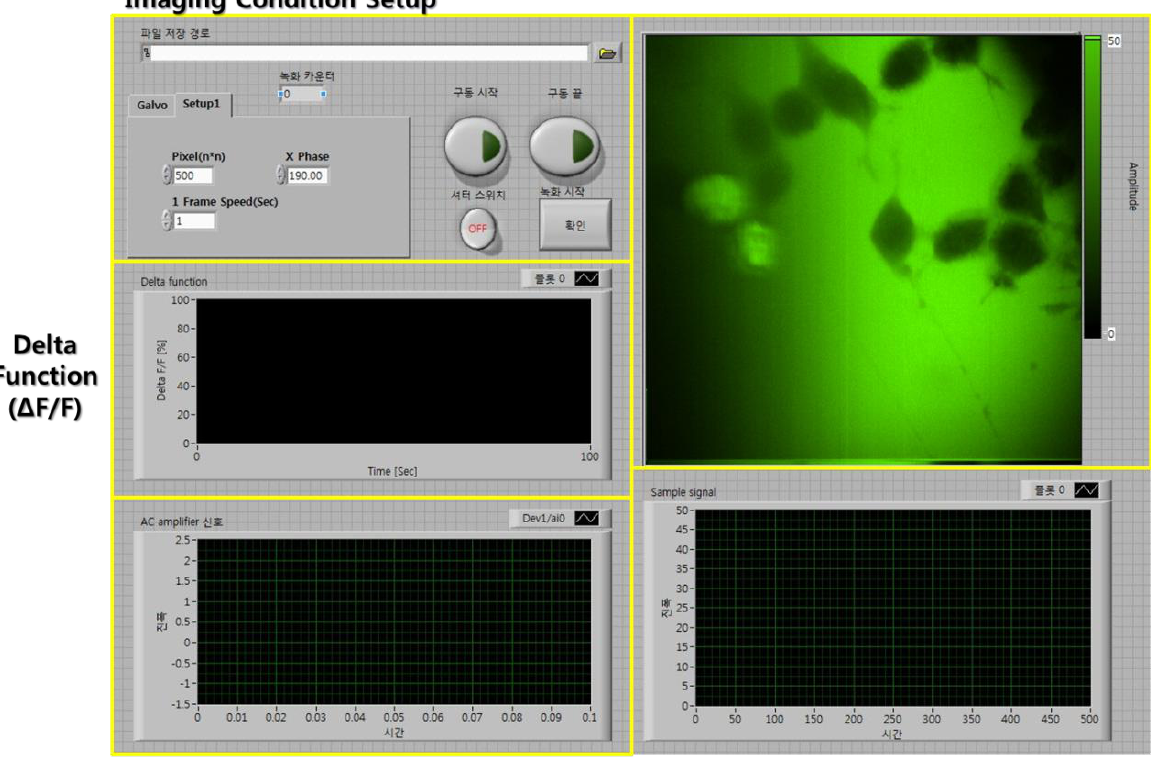
Figure 3. The main screen of the neural spike recording and fluorescence imaging program based on the